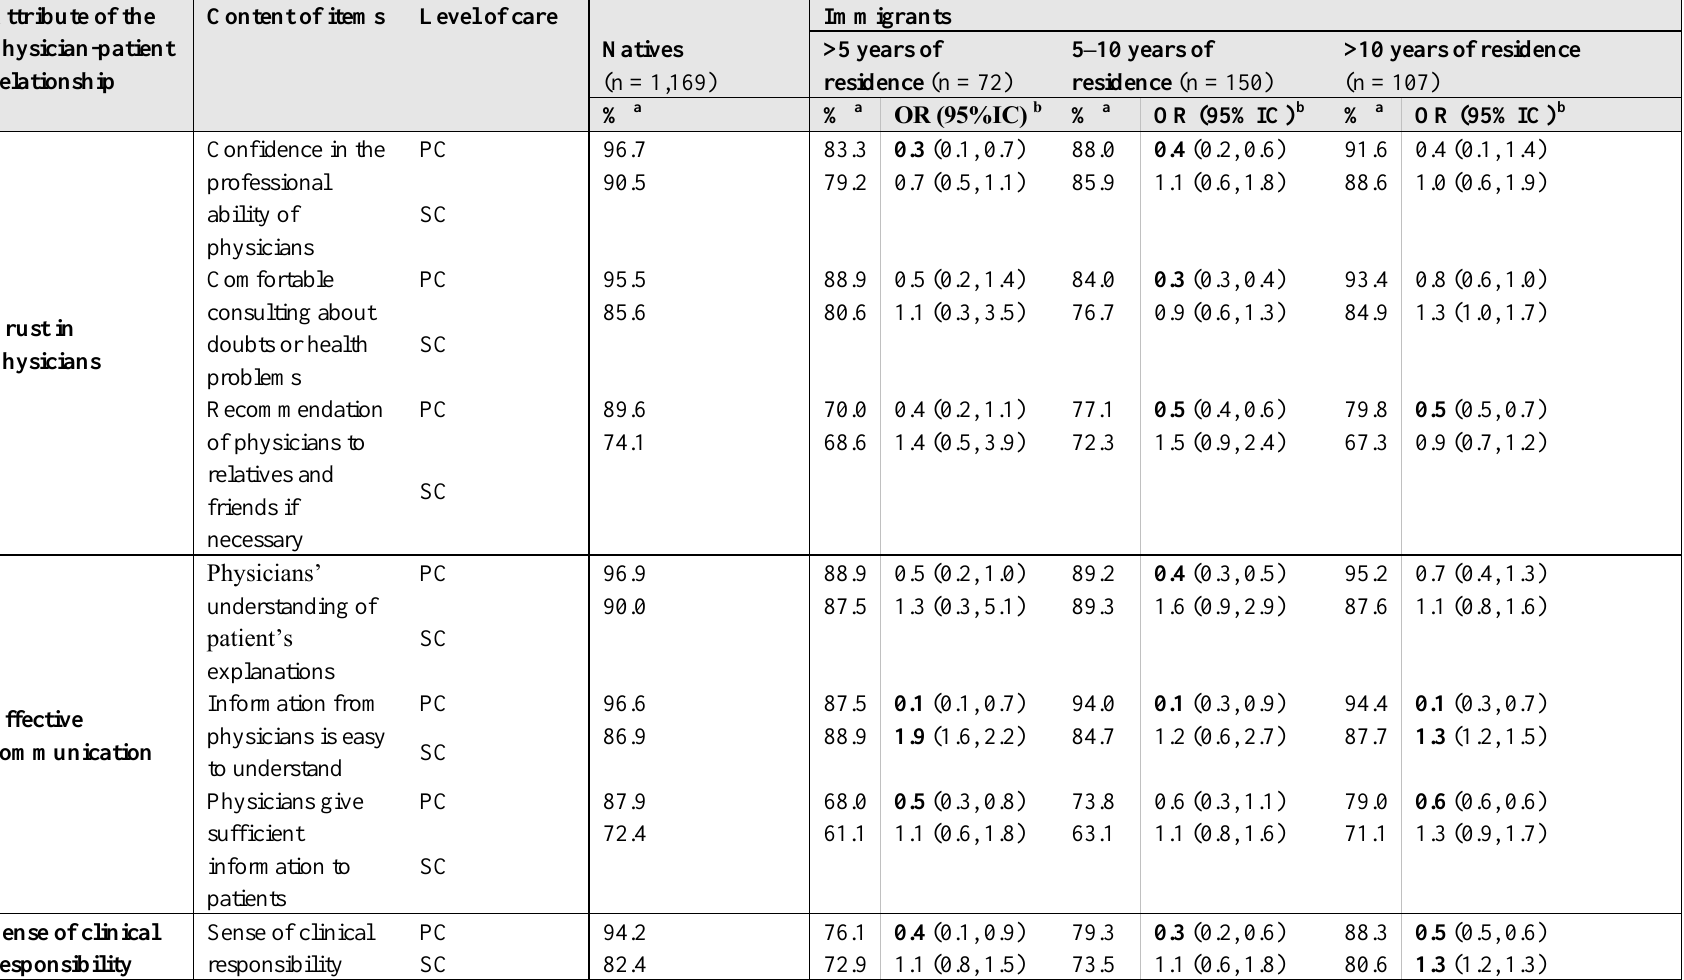
Table 3. Logistic regression models: association of immigration status with items from the physician-patient relationship scales. Attribute of the physician-patient